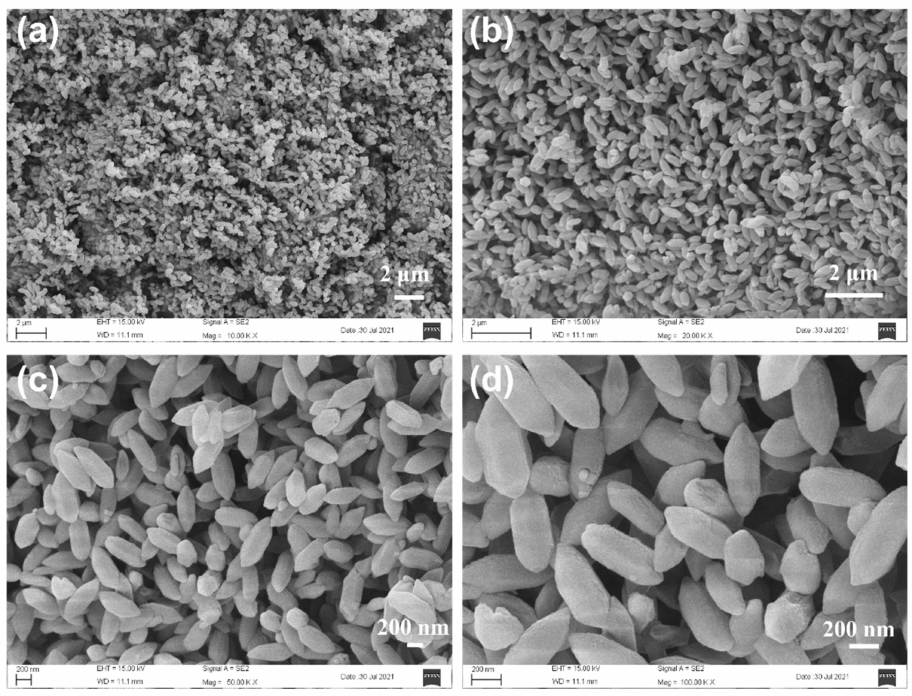
Figure 2. SEM images of MIL-88A(Fe) under different magnifications. ( a ) × 10,000 magnification, ( b ) × 20,000 magnification ( c ) × 50,000 magnification and ( d ) × 100,000 magnification.